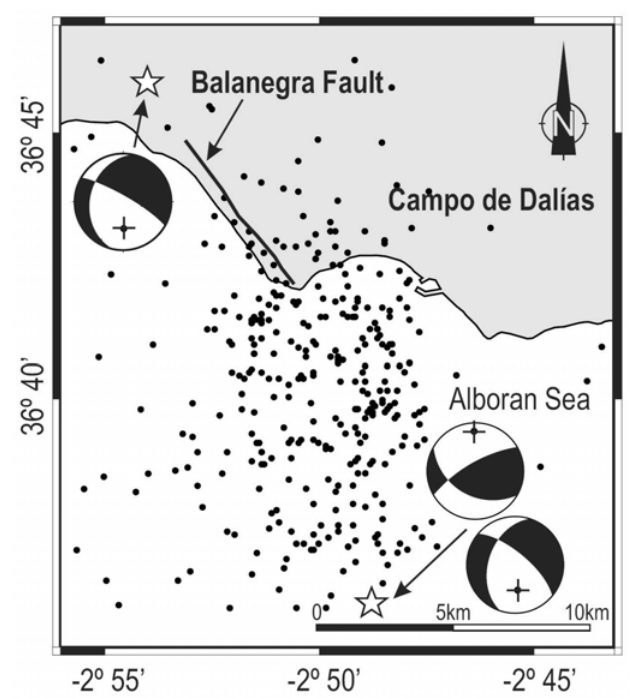
Figure 5. Epicentres and focal mechanisms near the Balanegra